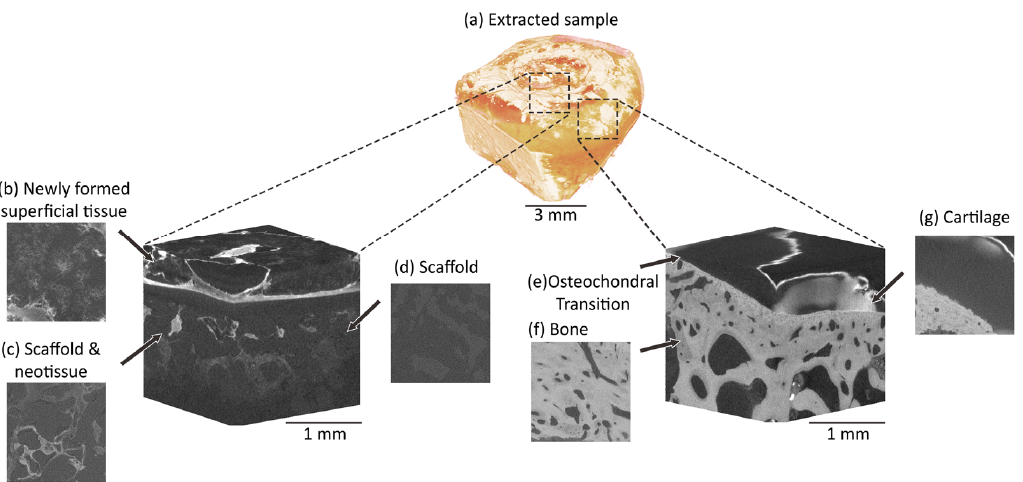
Figure 2. Micro-CT reconstructed volumes of the extracted sample following six weeks in vivo. The entire extracted sample ( a ) with two volumes of interest digitally extracted (indicated with dashed boxes) to encompass all system components: newly formed tissue ( b ) covered the scaffold implant ( d ), within which there were also regions of newly formed tissue ( c ). Surrounding the defect was articular cartilage ( g ), the osteochondral transition between the cartilage and bone ( e ) and the subchondral bone ( f ). These components were analysed with DVC software between pairs of repeated constant strain micro-CT scans. The constant strain study provided error analysis on all components of the tissue-biomaterial system. No image processing was been applied to the micro-CT slices.